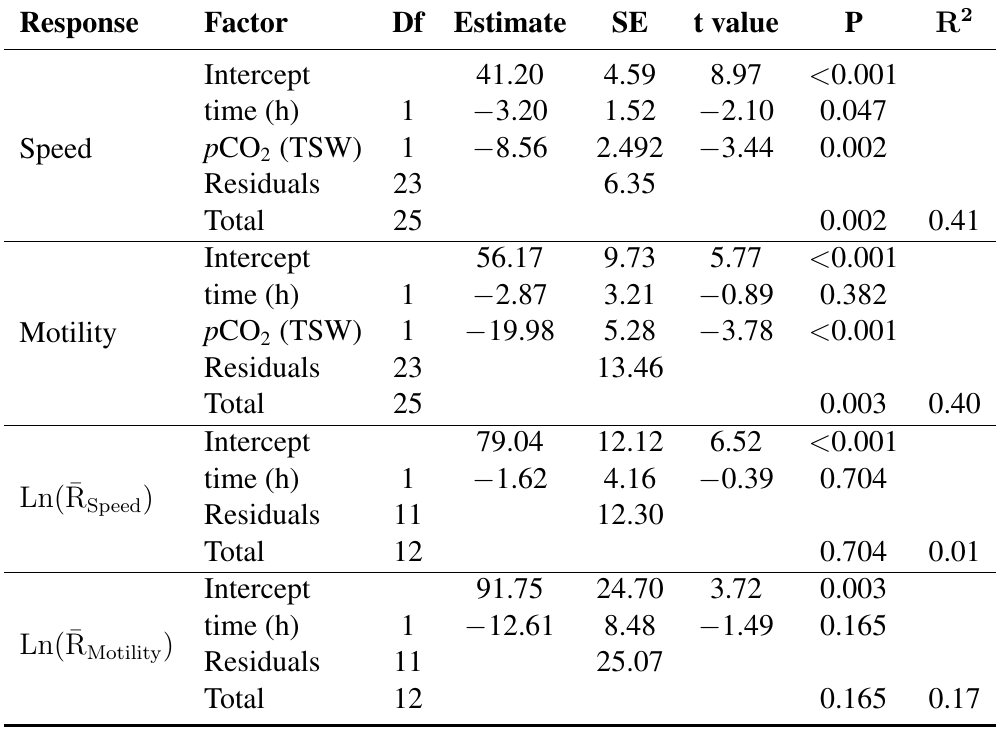
Table 2. Analysis of Covariance parameters for sperm swimming speed (Speed) and percentage of motile sperm (Motility), and regression analysis parameters for Ln response ratio Ln(¯ R) of sperm swimming speed and percentage of motile sperm. Time (h) means hours from spawning, and p CO (TSW) is the independent variable and states the 2 estimated difference from control p CO conditions. Df means degrees of freedom and SE 2 standard